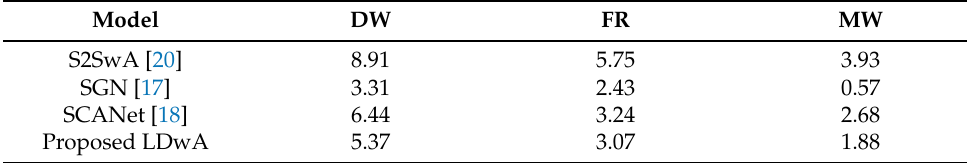
Table 4. Training time in hours for the REDD dataset.